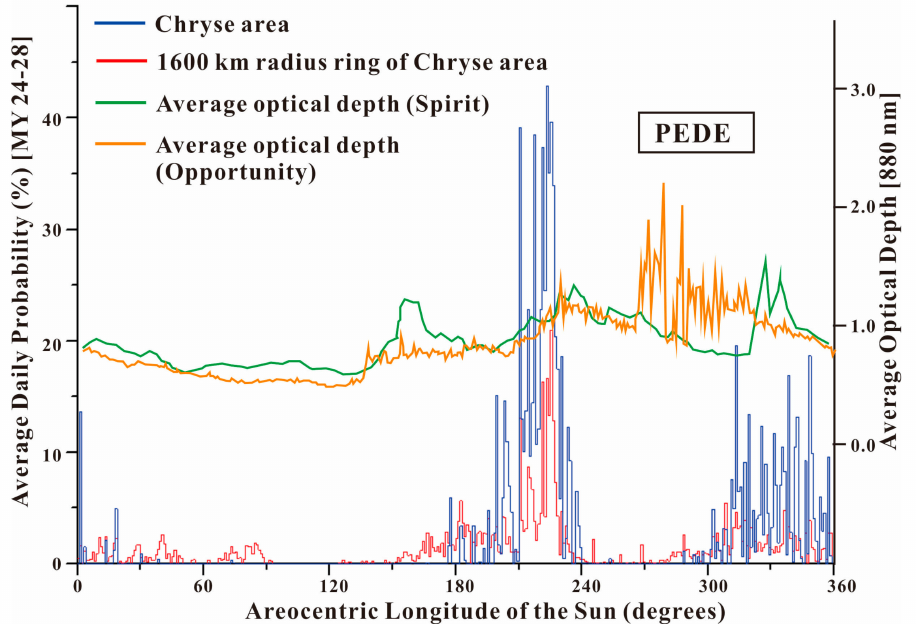
Figure 3. Daily mean dust storm frequency is proportional to the Ls of the Chryse area (blue color) and within its 1600 km-radius ring (red color) in 1 ◦ of Ls. The green and orange curves show